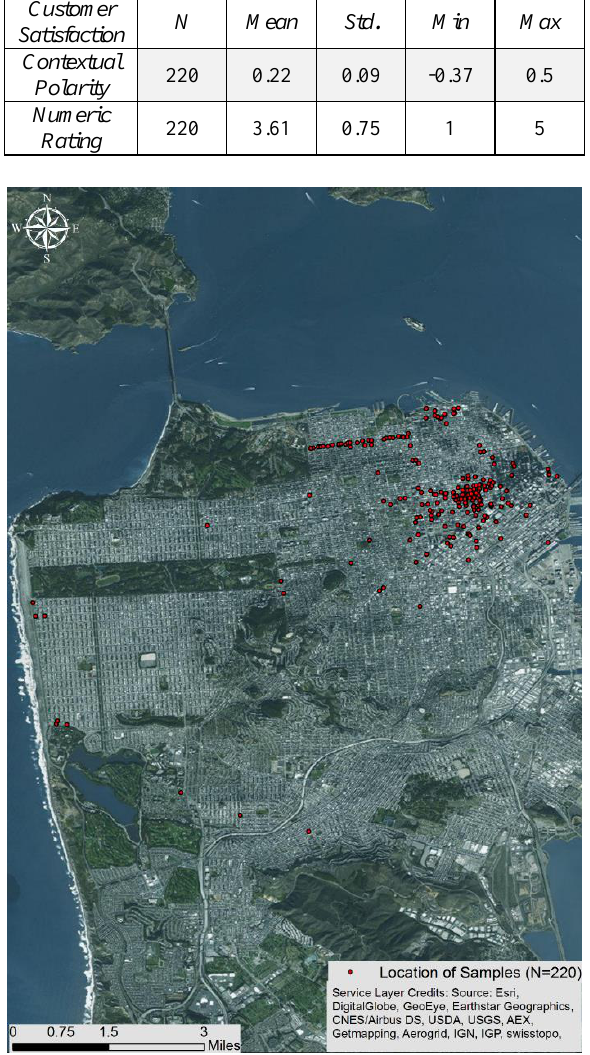
Figure 1. Geographical distribution of the 220 hotels in this study, San Francisco, CA,